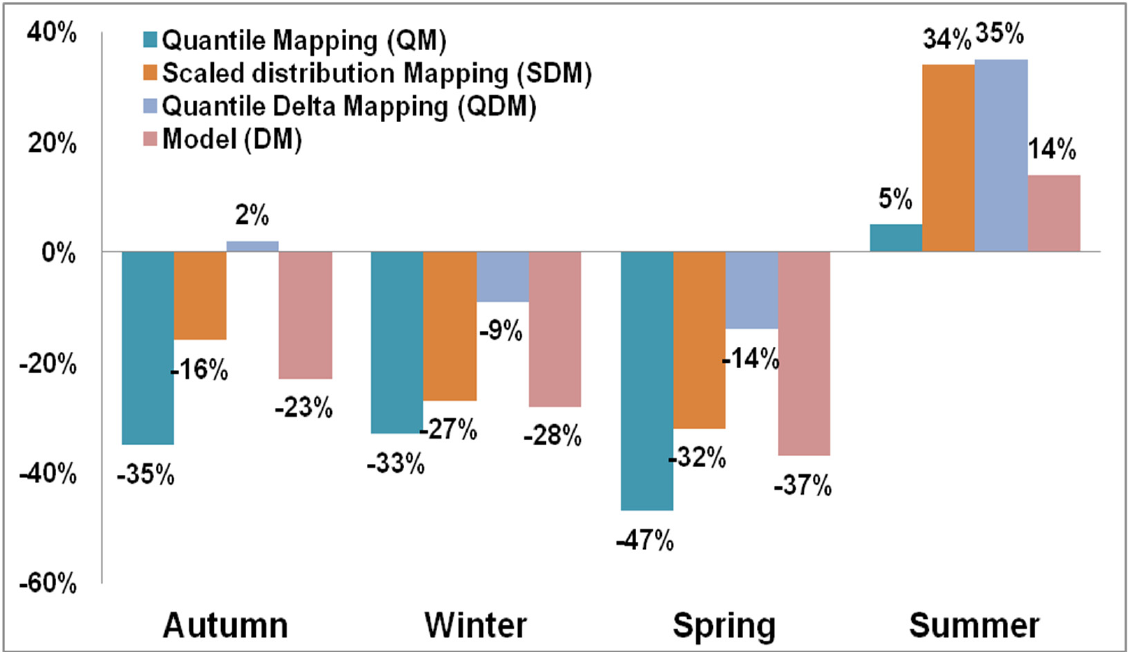
Figure 12. Seasonal precipitation mean variation over the CMT basins under the RCP4.5 and RCP8.5 climate scenarios.